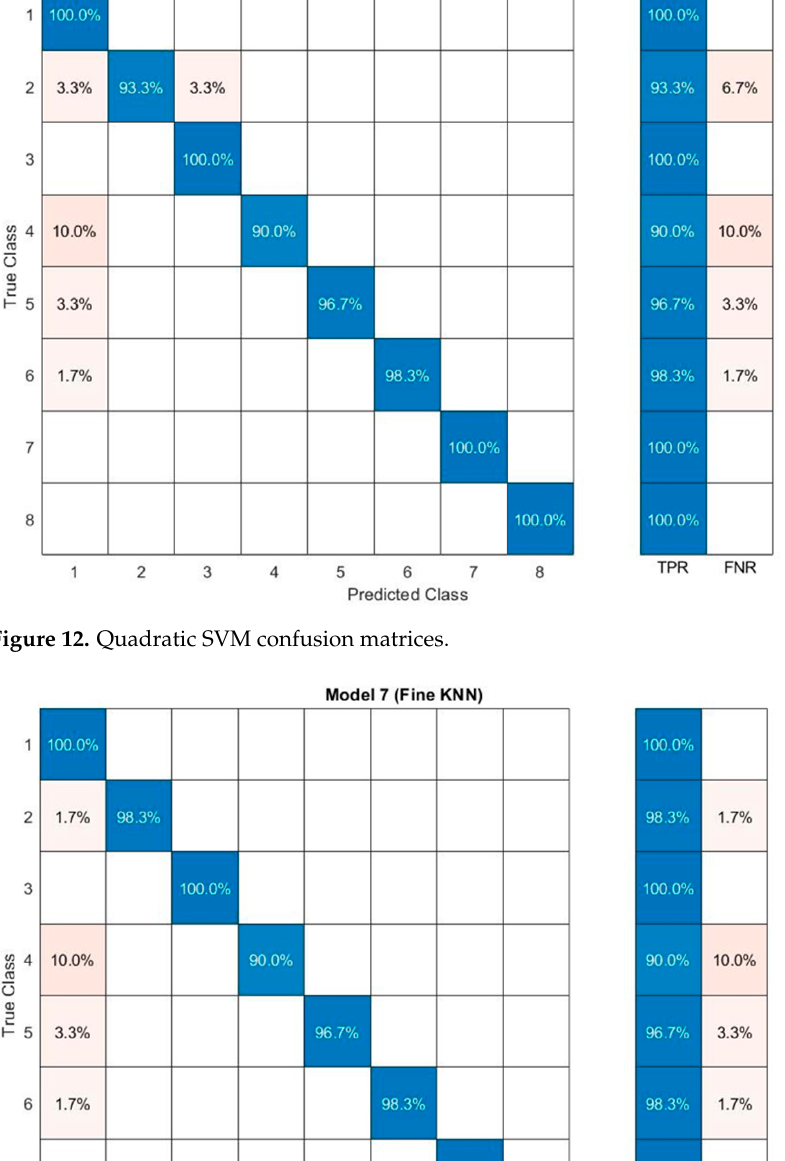
Figure 13. KNN model confusion matrices.